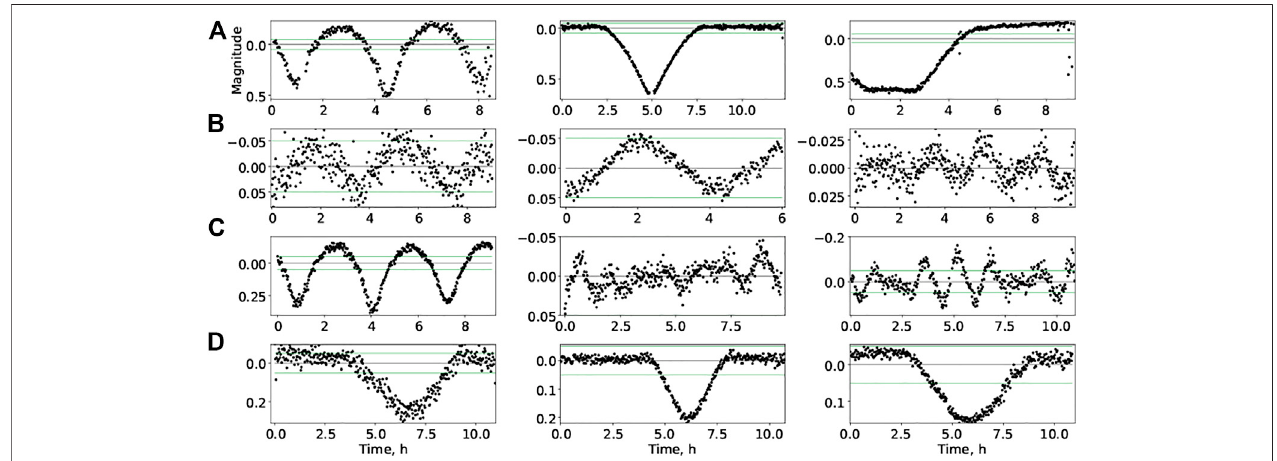
FIGURE8| Lightcurvesofvariablestars: (A) withlargeamplitudes( Δ m > 0.5 m ), (B) withsmallamplitudes( Δ m < =0.1 m ), (C) withshortperiods( P < 4 h ),and (D) with a shape similar to a transit event. The horizontal lines show the ±0.05 m zone.